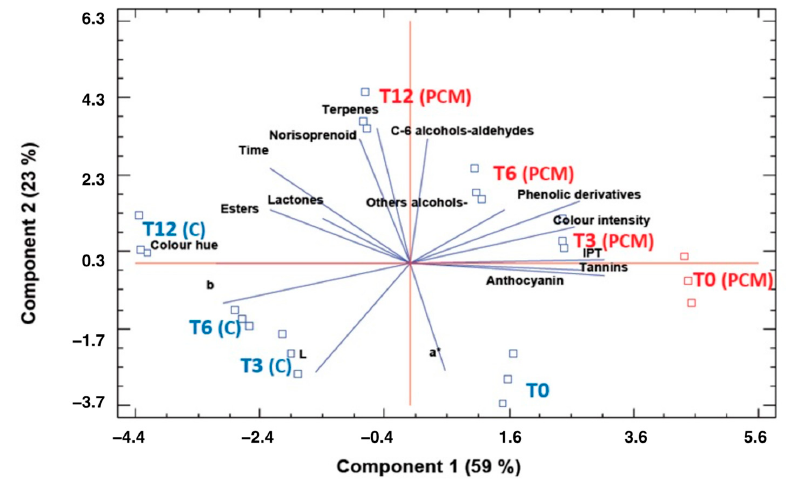
Figure 5. Scores of the samples and variables in the plane are defined by the two principal components. Tempranillo wines with aging time in bottle. T0: time zero; T3: 3 months after bottling; T6: 6 months after bottling; T12: 12 months after bottling.